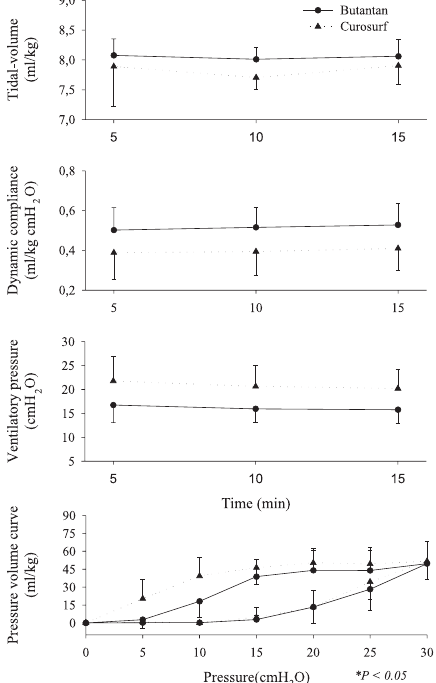
Figure 3 - Time point 1 (24 hours after removal from refrigerator and kept at room temperature (24 o C) before being warmed to 37 o C for 5 minutes): data for tidal-volume (V ), dynamic compliance (DC), ventilatory pressure t (VP), and pressure-volume curve (mean ± SD) were analyzed by the Student t test (parametric data) or Mann-Whitney test (non-parametric data).